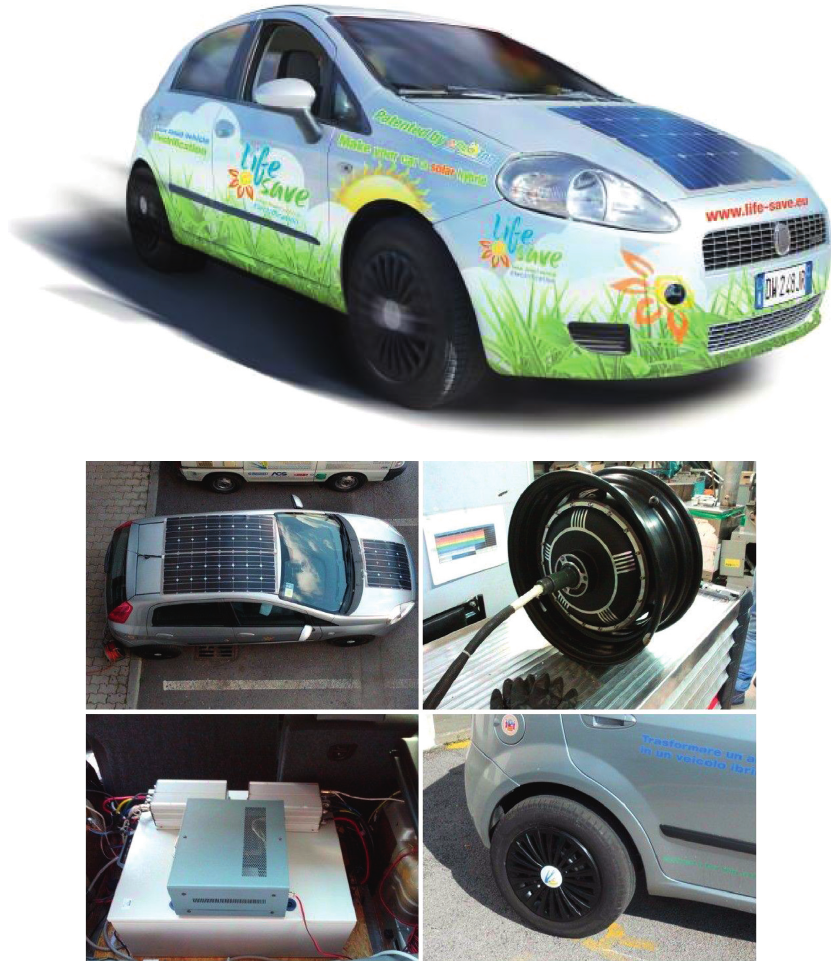
Figure 5: HySolar kit (HSK)-vehicle